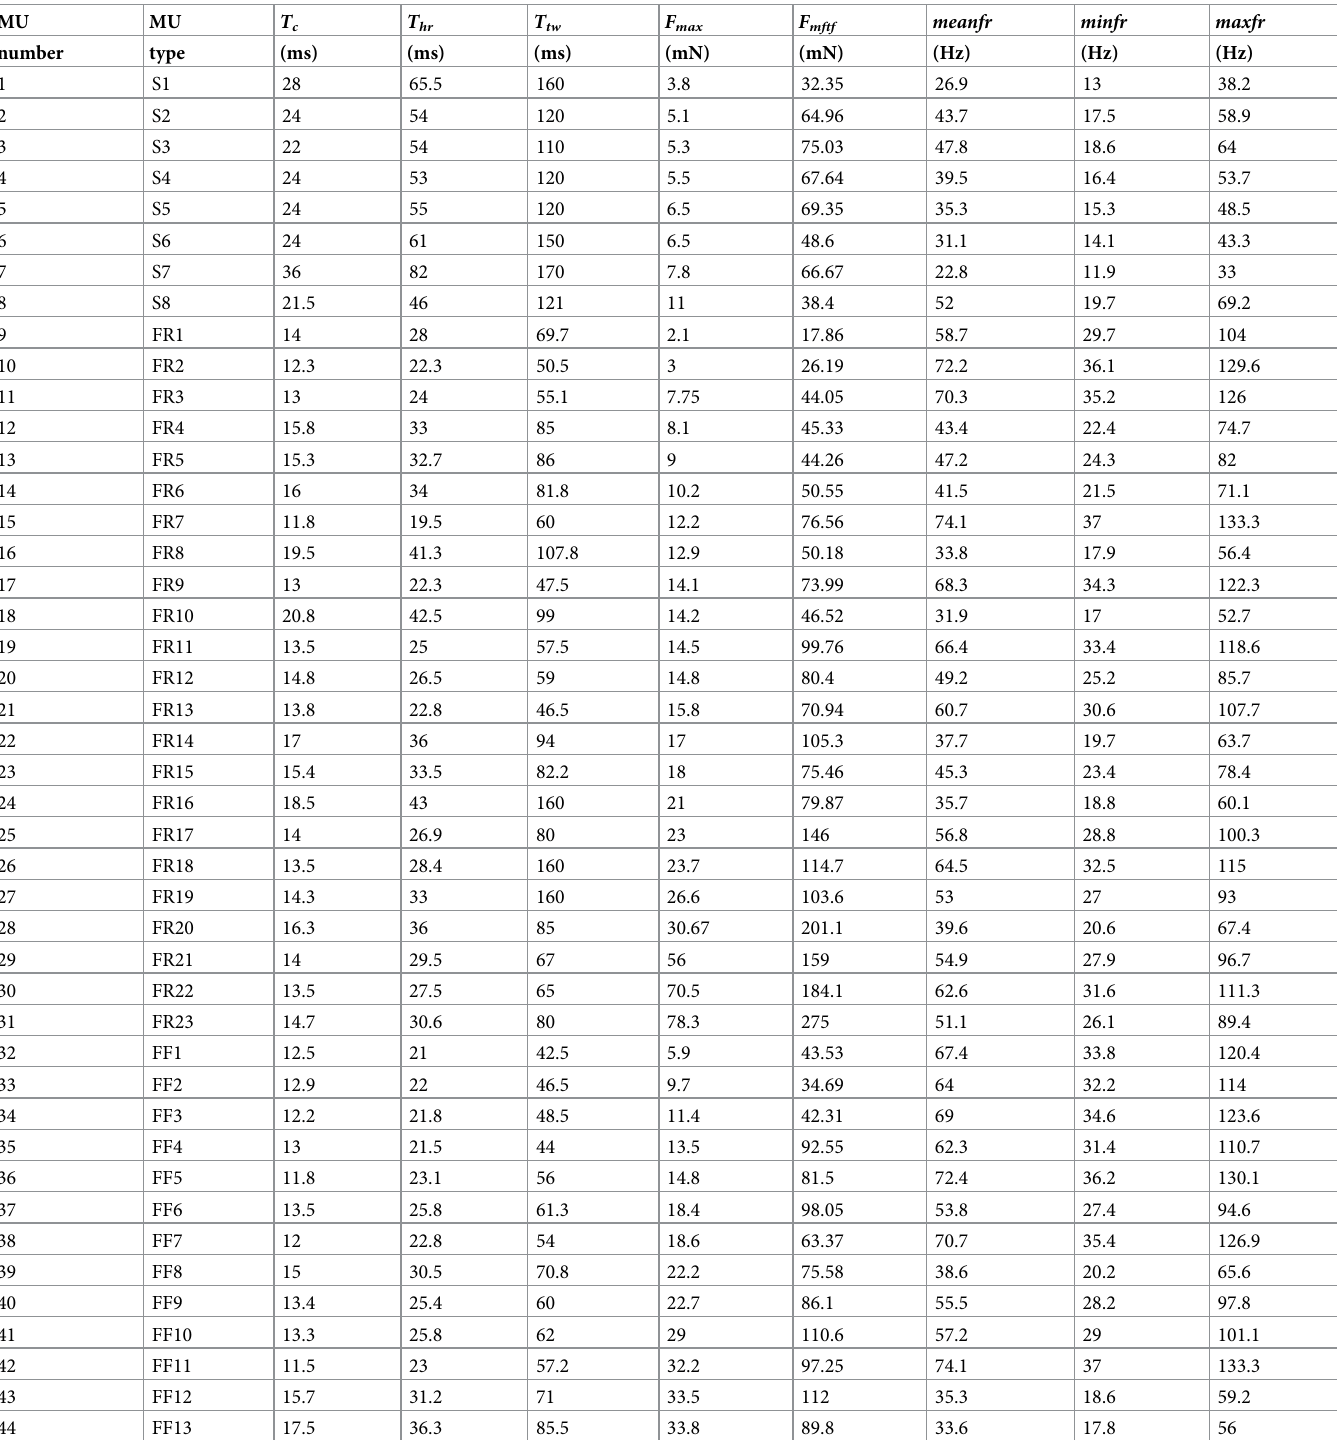
Table 1. Main input data for the muscle model: values of the basic contractile properties of the 57 MUs (slow, S1–S8; fast resistant to fatigue FR1–FR23; fast fatiga- ble FF1–FF26) selected for the muscle modeling and their firing properties. T c – the contraction time; T hr –the half-relaxation time; T tw –the duration of the twitch; F max –the maximum force of the twitch; F mftf – the maximum force of the fused tetanus; meanfr –the mean frequency of rhythmic firing; minfr –the minimum rhythmic fir- ing frequency; maxfr –the maximum rhythmic firing frequency. Data are taken from Table 1 in Raikova et al.